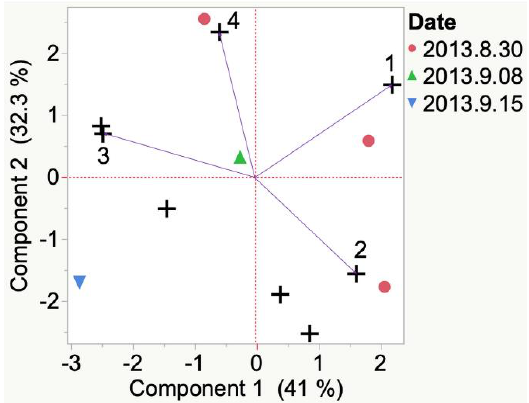
Figure 8. Evolution of VOCs emitted from single berry from veraison to harvest of 2013 St. Croix grapes grown in South Dakota. Key to most representative volatiles from HCA, shown as vectors from the origin and read clockwise: 1 = 2-Phenylethanol, 3 = Diacetone alcohol, 4 = Acetic acid, 2 = 6- Methyl-5-hepten-2-one.